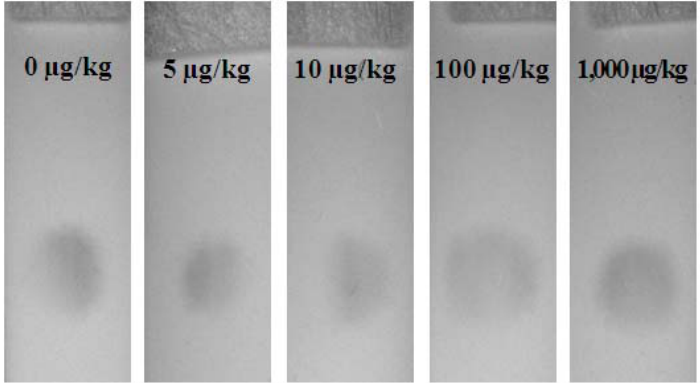
Figure 6. Cross-reactivity test results using